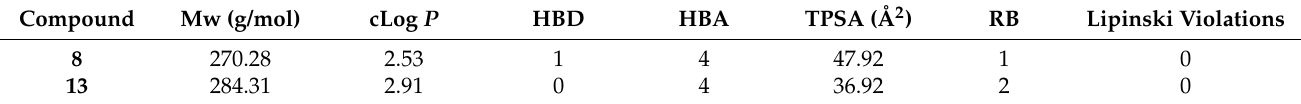
Table 5. Physicochemical parameters and Lipinski